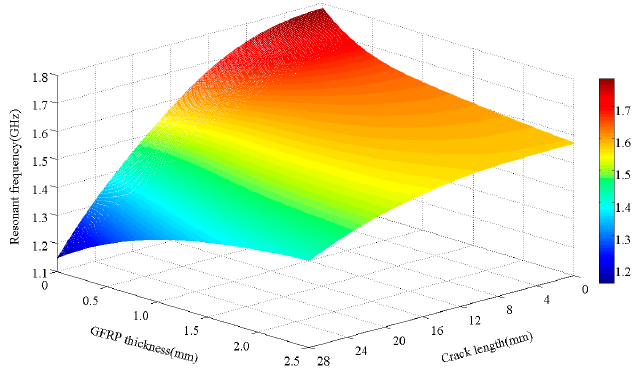
Figure 11. Resonant frequency–GFRP thickness–crack length characteristics in a 3D diagram.